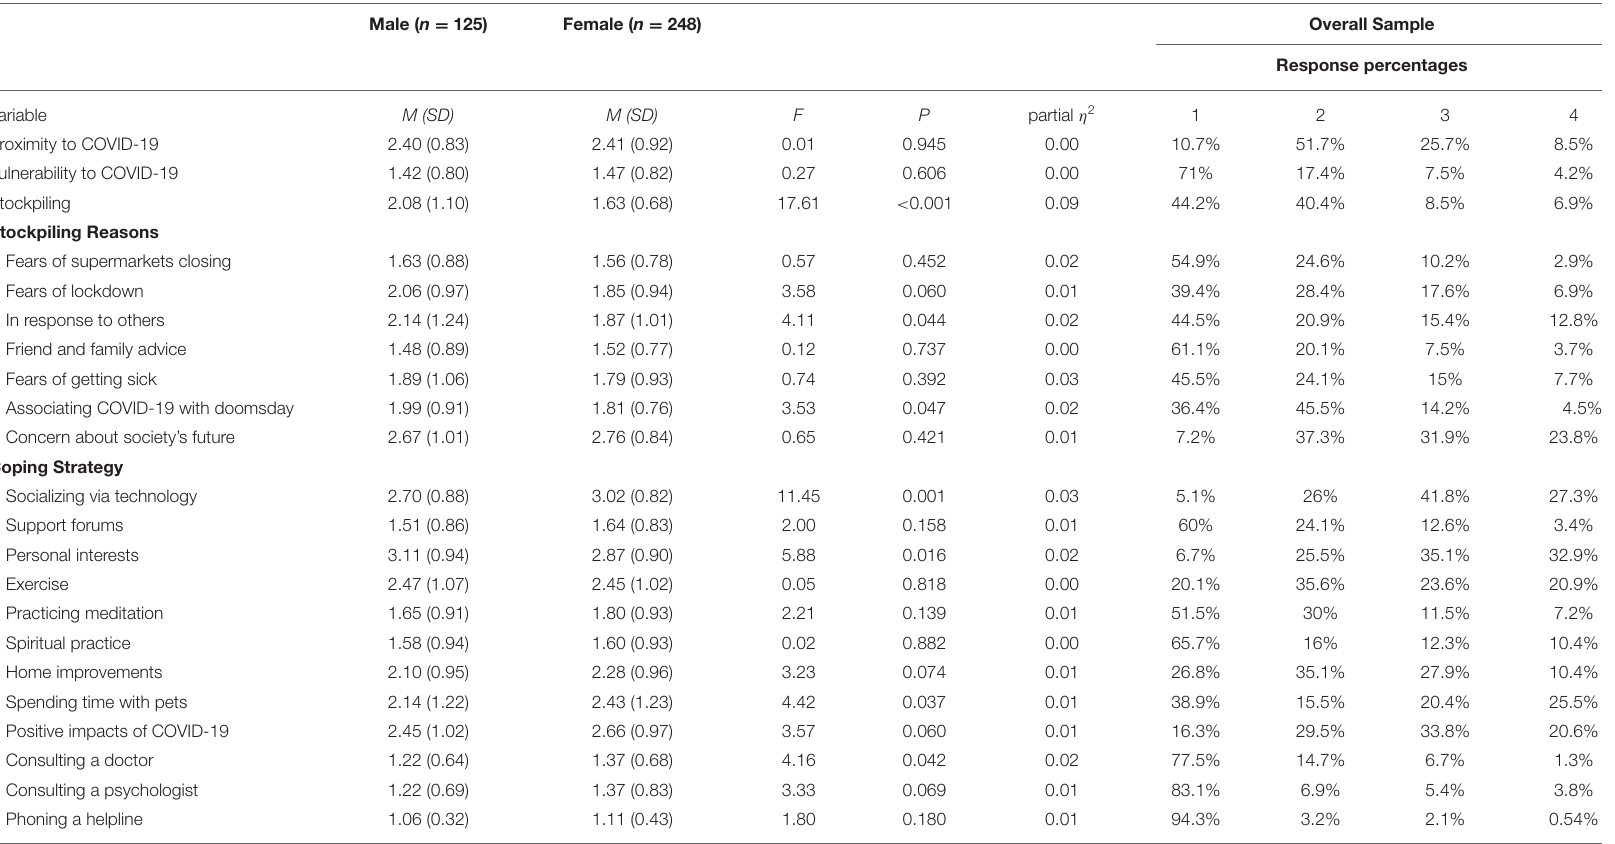
Scores correspond to the following qualitative descriptors of the response scale: 1 = Not at all, 2 = Somewhat, 3 = Moderately, 4 = Very much so. Participants who did not answer the gender question (n = 5) were excluded from the gender comparative